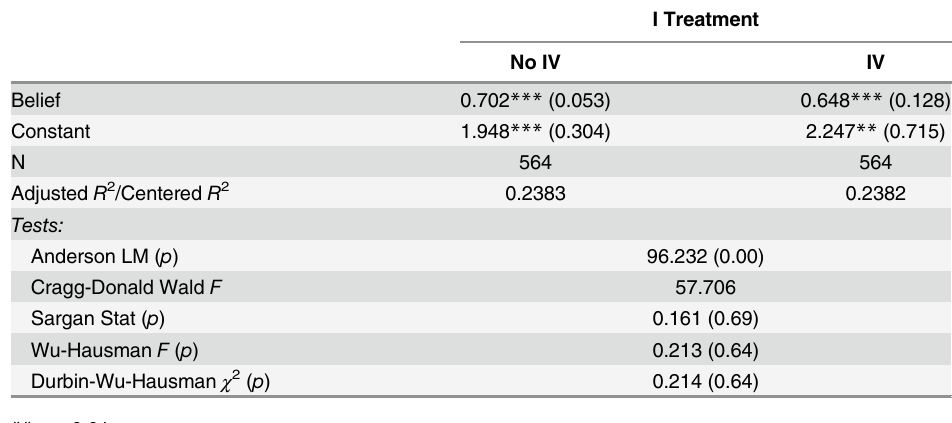
Table 4. Relationship between Allocations and Beliefs in a One-Shot TPG: with and without